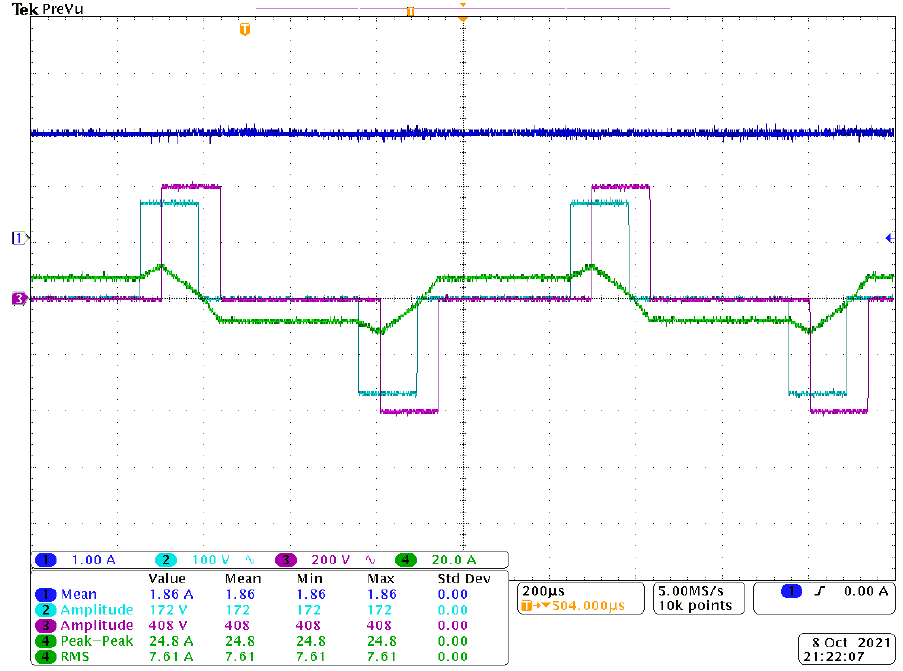
Figure 23. DAB operation at low power under the DPS-based